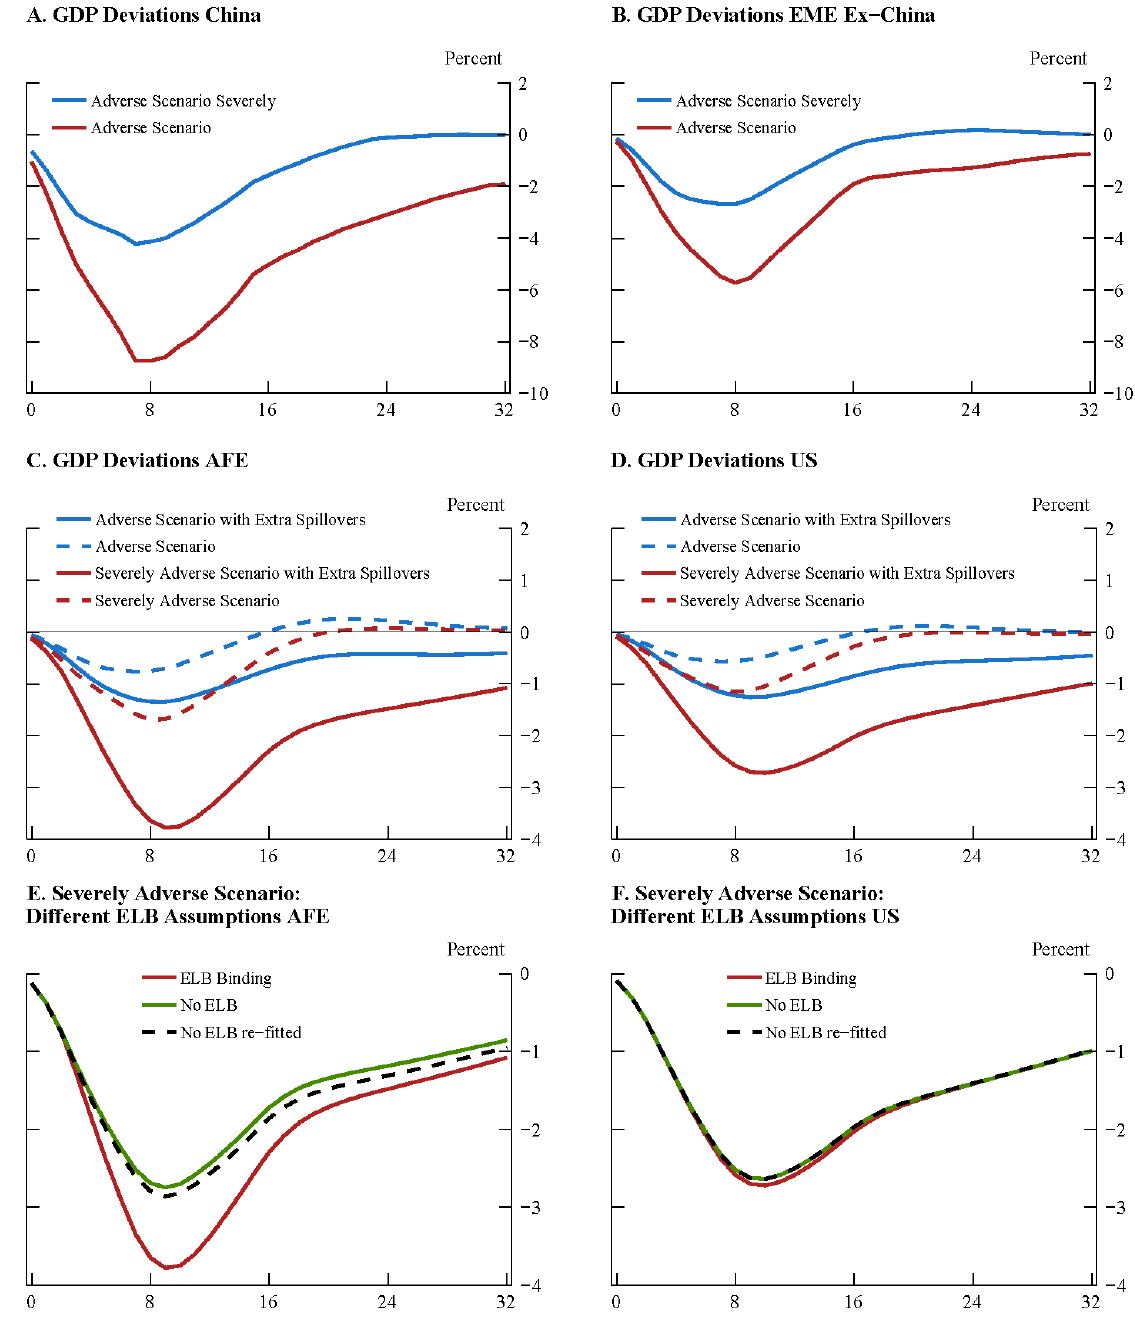
Figure 9. GDP simulation results from SIGMA. Source: authors’ calculations.